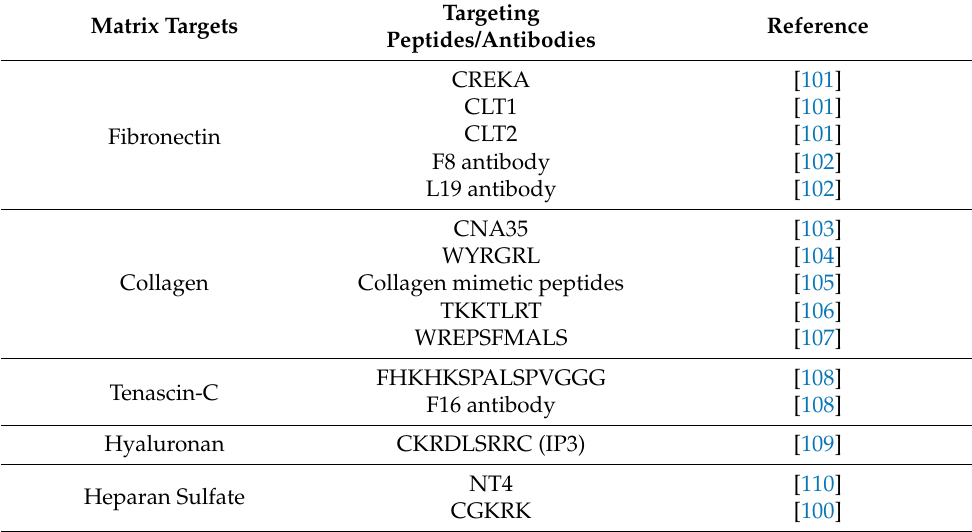
Table 3. Extracellular matrix components and associated targeting